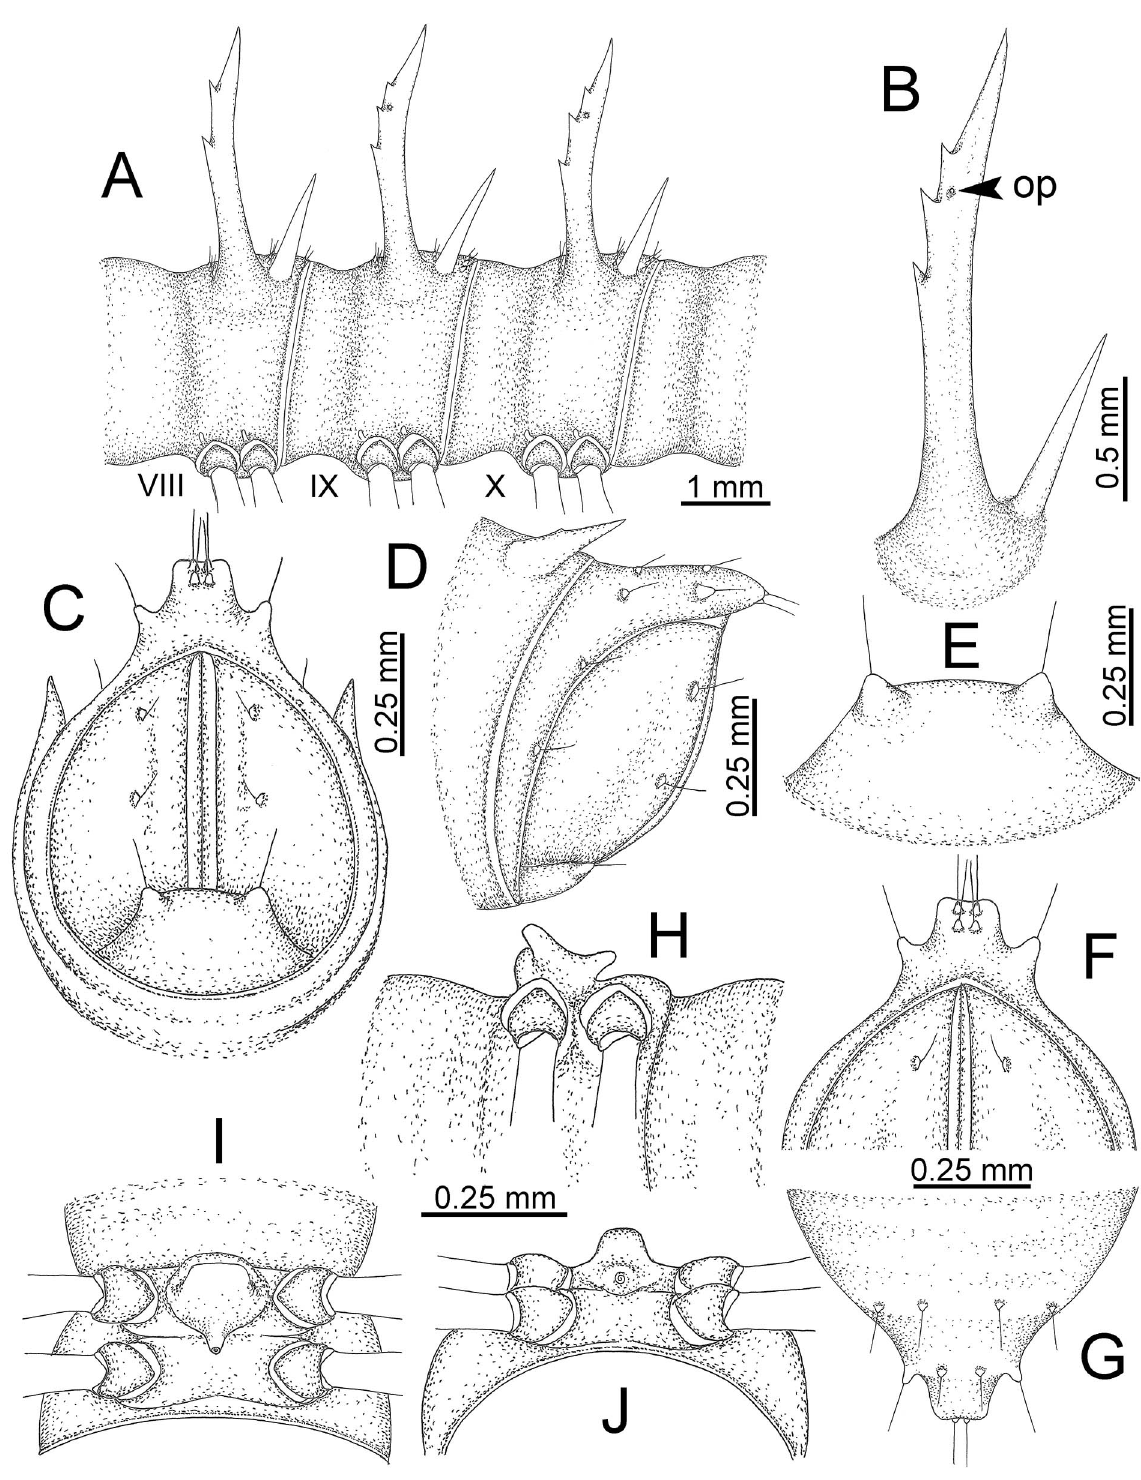
Fig. 6. Gigaxytes fusca Srisonchai , Enghoff & Panha gen. et sp. nov., ♂ paratype. A . Body rings 8–10. B . Paraterga of ring 10 (arrowhead points to ozopore). C – D . Last ring and telson. E . Hypoproct. F – G . Epiproct. H – J . Sternal lobe between coxae